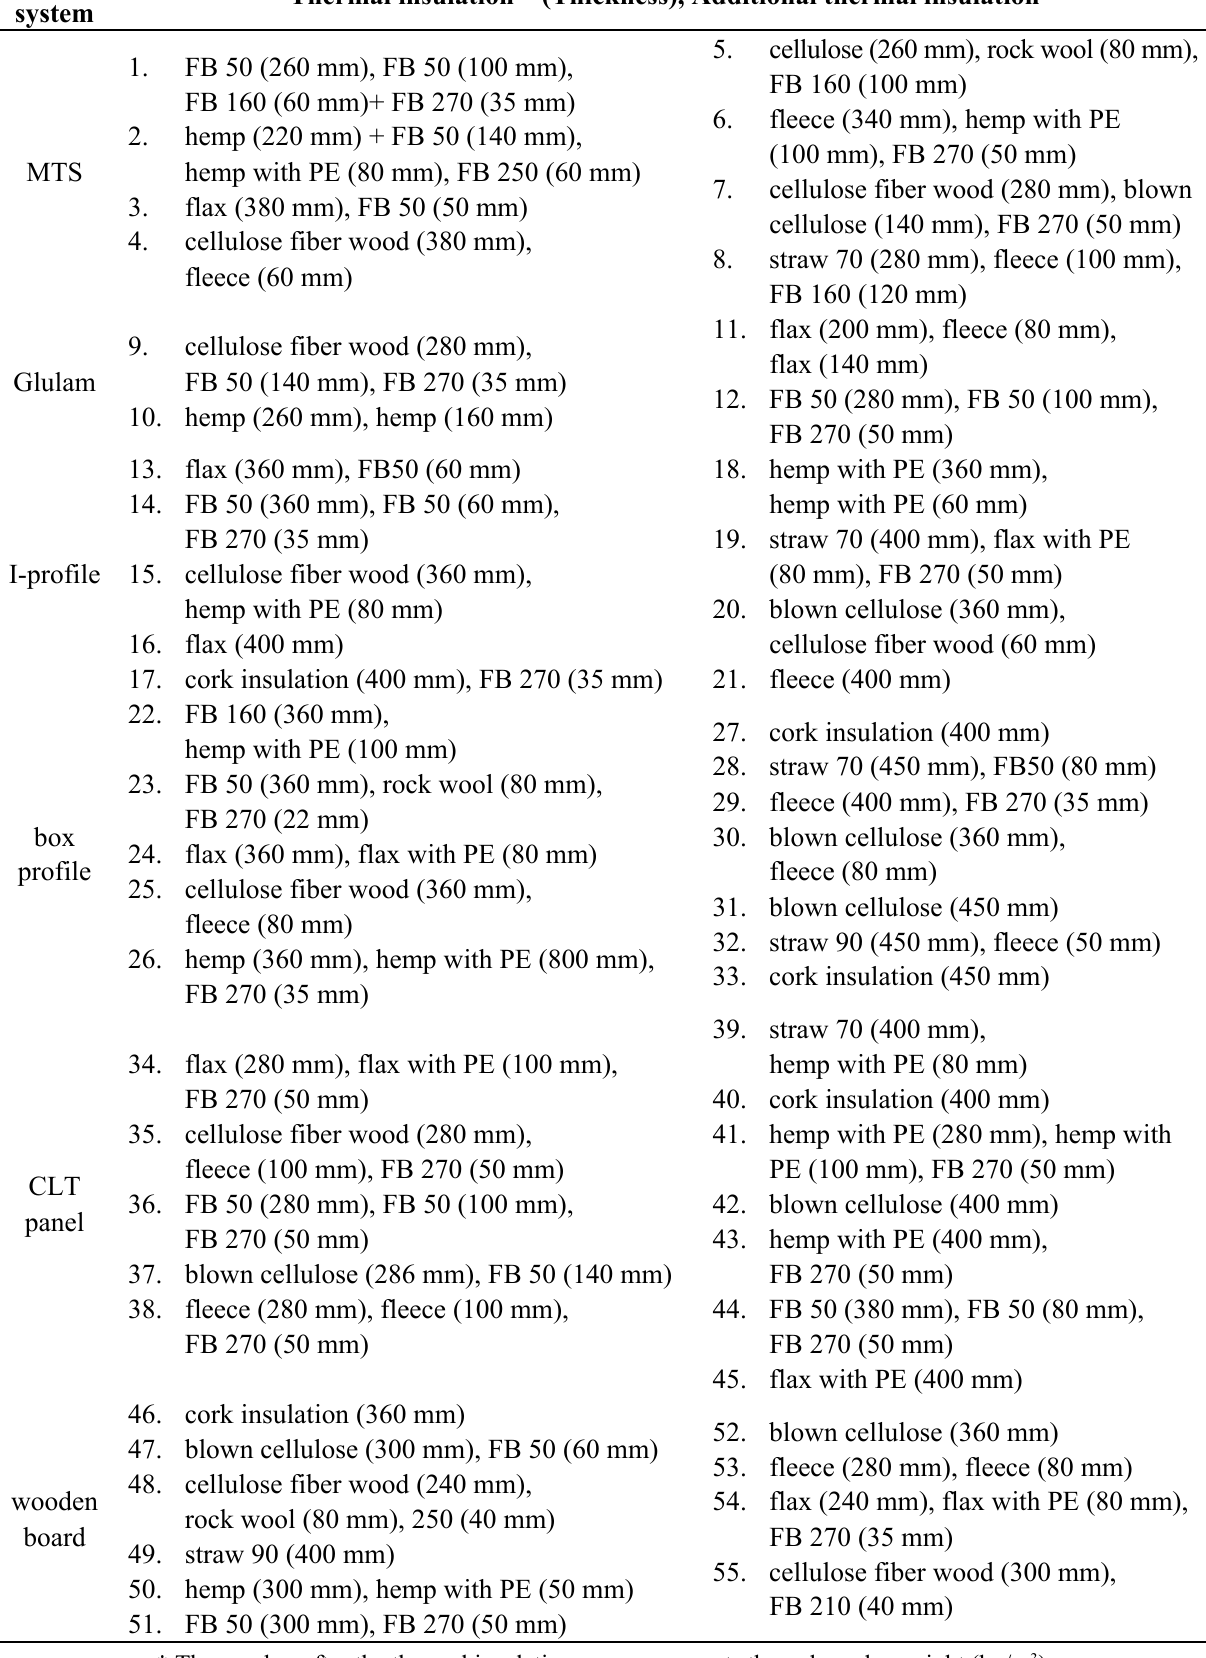
Table 4. Description of roof